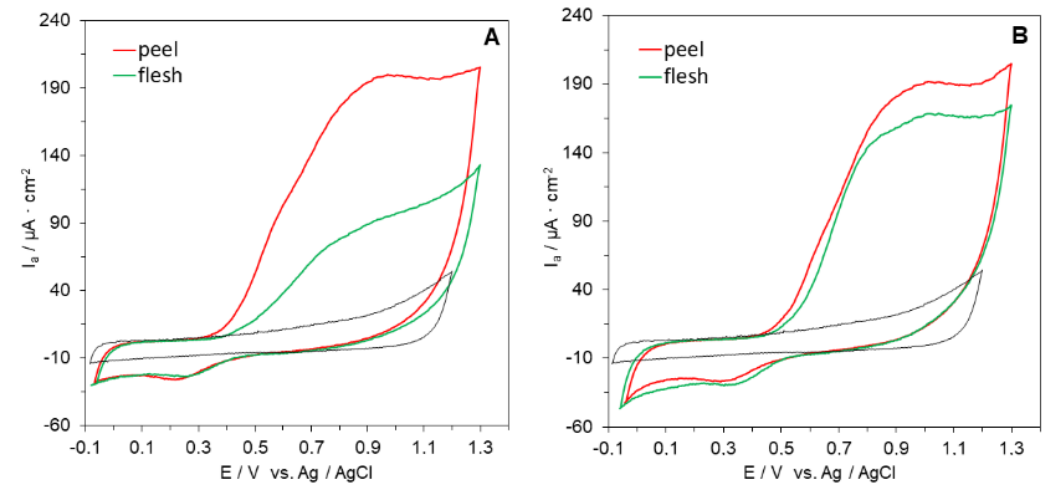
Figure 1. Cyclic voltammograms of peel and flesh extracts of selected apple cultivars: ( A ) Jonagored, ( B ) Anton ó wka. CV of electrolyte solution shown as dotted gray line. Operative conditions: extract concentration 25 mg / mL; pH 6.0; scan rate 0.1 V / s.